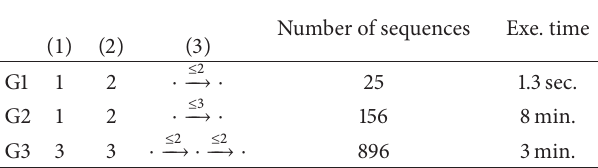
Table 4: Experiment results for test sequence